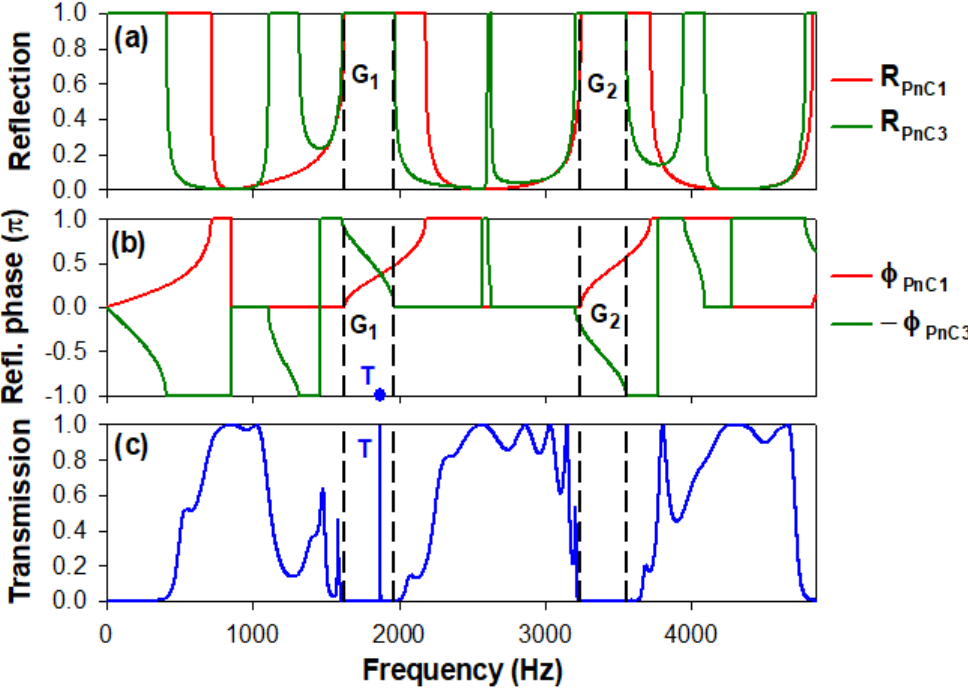
Figure 6. ( a , b ) Reflection amplitudes and the corresponding phases at the boundary of each PnC with the waveguide system (Figure 1b). The first PnC (PnC1) is made by stubs of length d (cid:48) and period of length d 1 = 2 cm, while the second PnC (PnC3) is made by stubs of length d (cid:48) and period of length d 2 = 13 cm. The blue dot in (b) indicates the position of the interface state. ( c ) Transmission coefficient for two finite connected PnCs, each one is made of N = 3 stubs (Figure